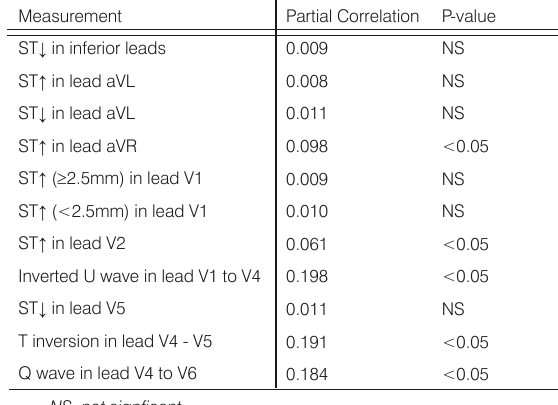
Table 5. Partial correlation coefficients relating different ECG parameters to proximal LAD lesion. Measurement Partial Correlation P-value